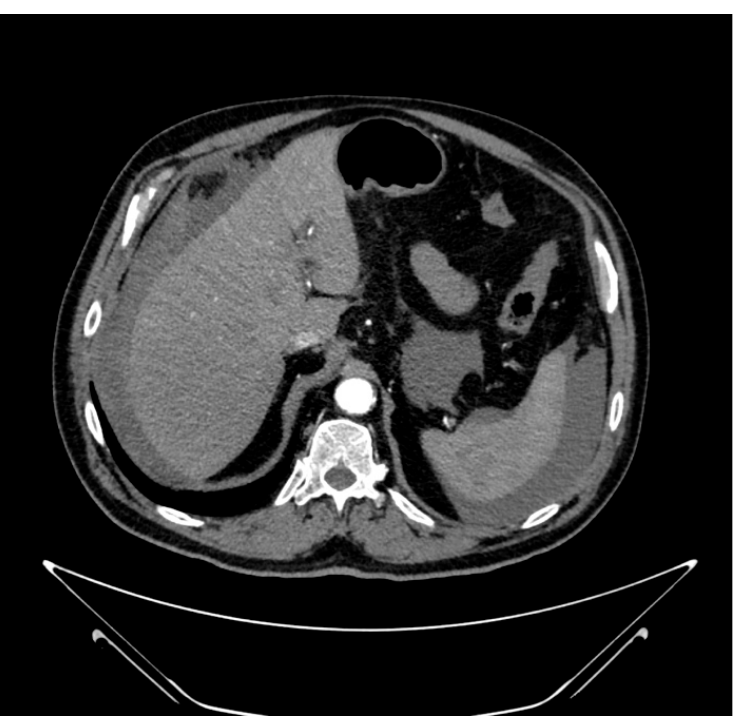
Figure 1. CT-Scan: peritoneal blood effusion is clearly visible around liver and spleen.